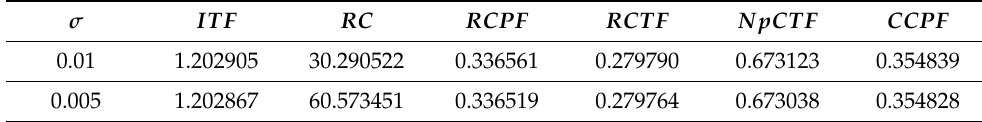
Figure 5. Comparison of the pre-limit (solid line), asymptotic (dashed line), and diffusion (dotted line) distributions for σ = 0.005 and λ = 1.5 ( ∆ AA = 0.0290 and ∆ ADA = 0.0012). As an example, Table 2 shows the values of these characteristics for λ = 0.9. Table 2. Characteristics of the system ( λ =